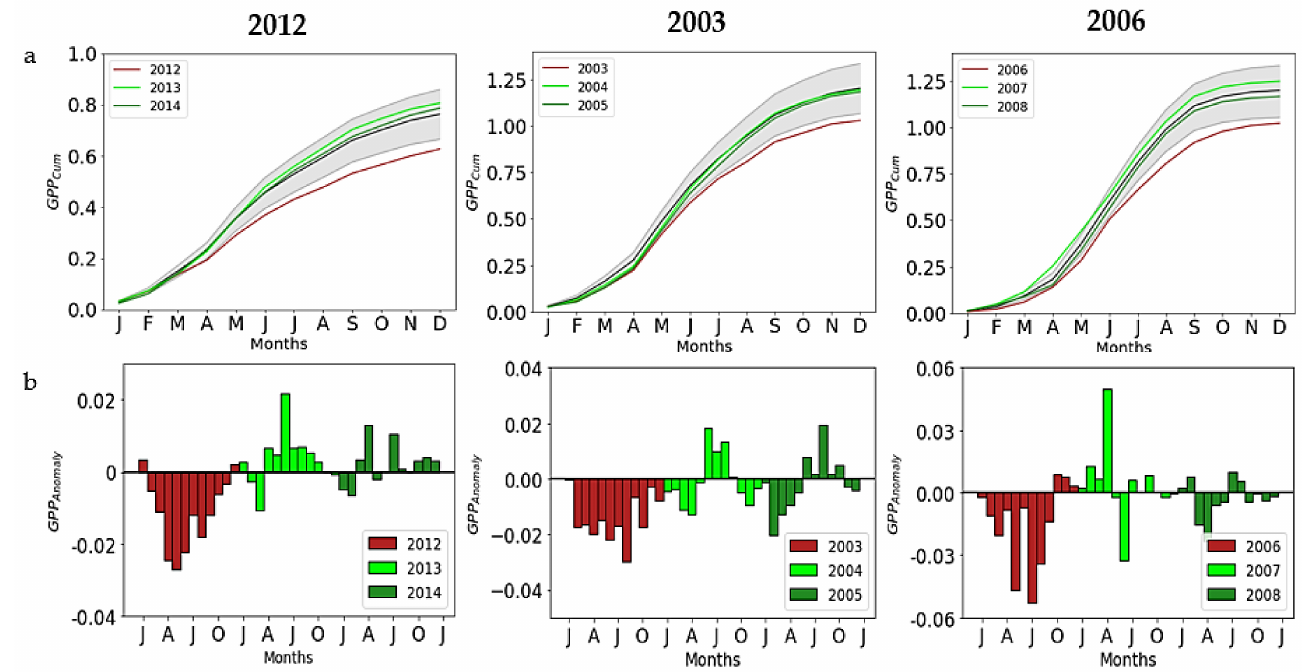
Figure A2. As in Figure 3 but over IB during 2012 event (left panels), EM during 2003 event (central panels) and WE during 2006 event (right panels).